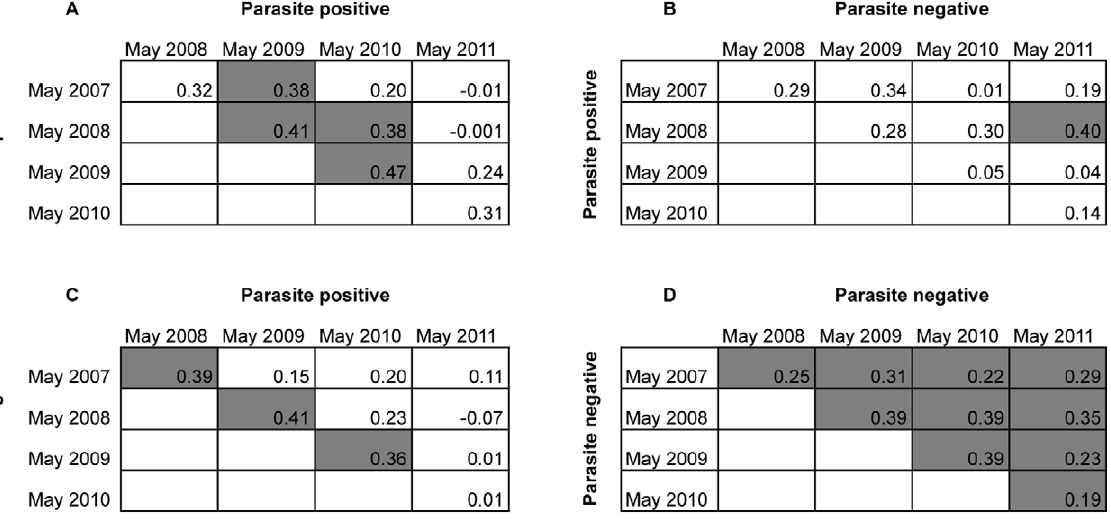
Figure 2. Comparison between ML ratios measured at different cross-sectional surveys. Spearman rank correlation coefficient is used to assess the relationship between ML ratios across different surveys according to parasite positive/negative status at the time the ML ratio was measured. Results are shown for children that were parasite positive at the May 2007 or 2008 or 2009 or 2010 survey and parasite positive (A) or parasite negative (B) in subsequent surveys (that is 2008–2011). In (C) and (D) results are shown for children that were parasite negative at the May 2007 or 2008 or 2009 or 2010 survey and parasite positive (C) or parasite negative (D) in subsequent surveys (that is 2008–2011). Rho values from all comparisons are shown and statistically significant comparisons (P , 0.05) indicated in shaded boxes. Unshaded boxes represent comparisons that showed no significant correlation.